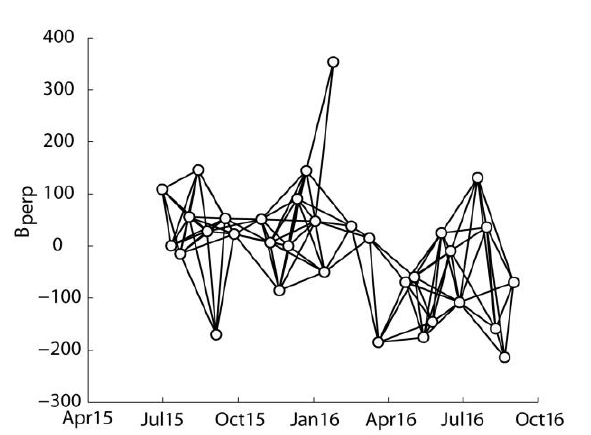
Figure 2. Baseline-time plot of the TerraSAR-X data in ascending geometry